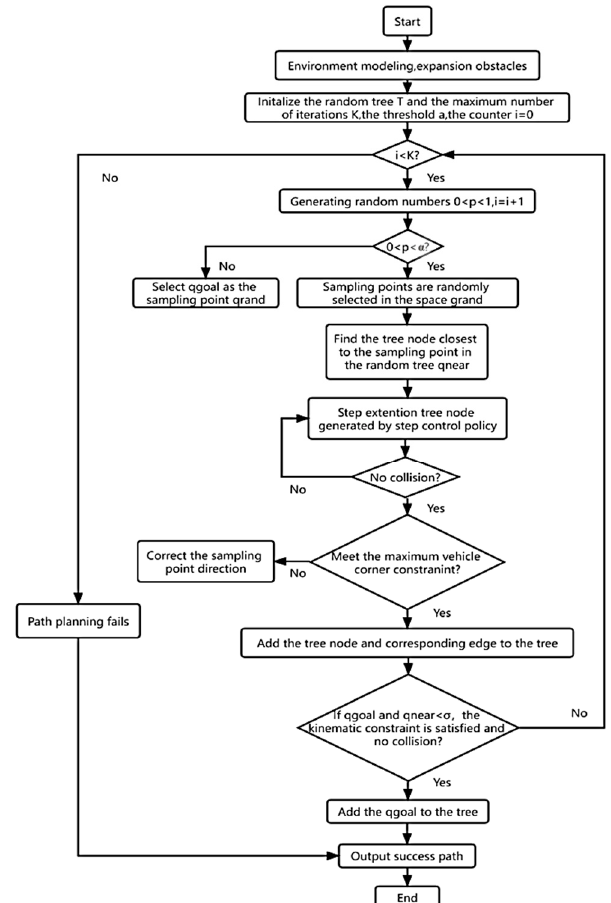
Figure 2. Flow Chart of the AV-RRT algorithm.